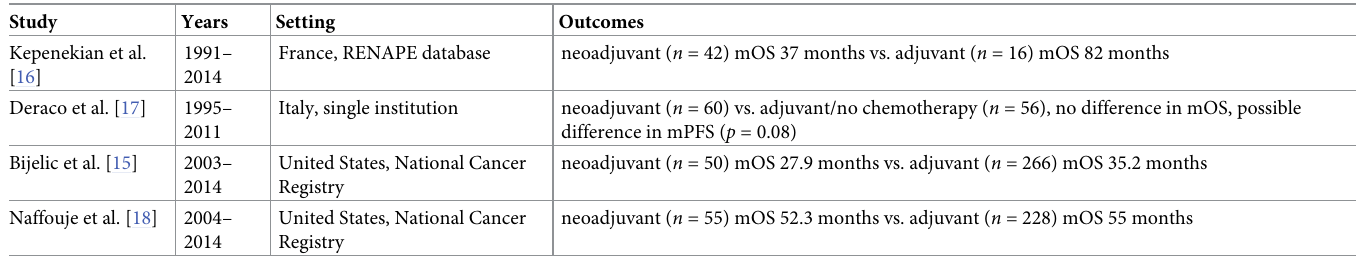
Table 1. Summary of existing literature regarding neoadjuvant vs adjuvant chemotherapy in DMPM.